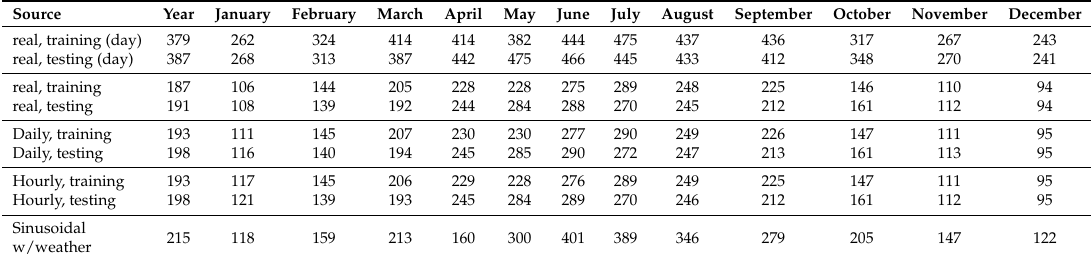
Table 5. Yearly and monthly average powers for Golden, Colorado (W/m 2